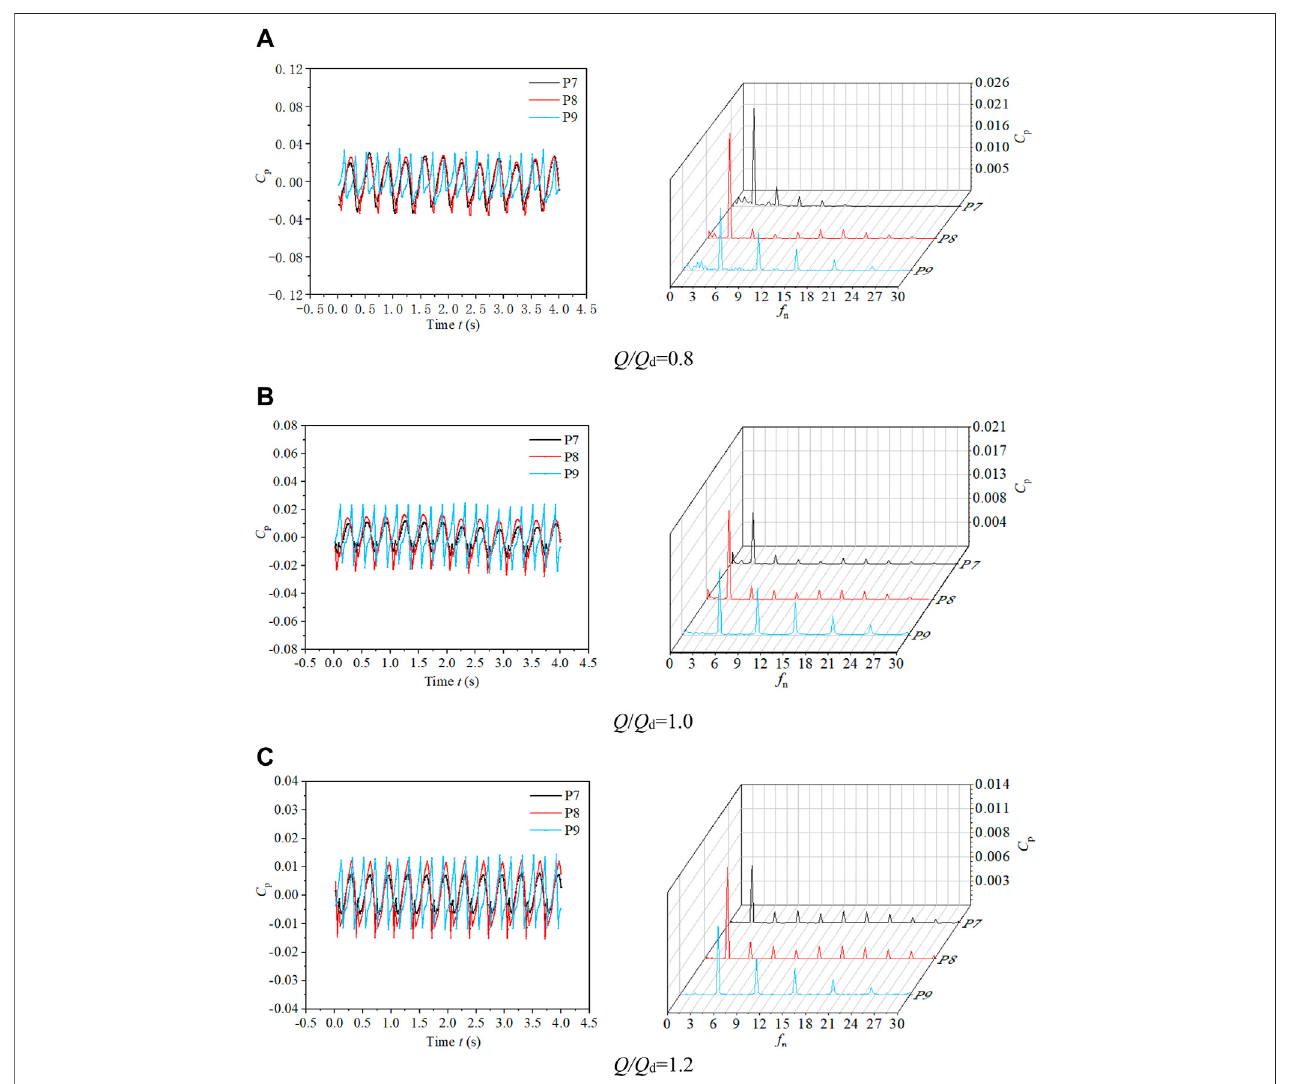
FIGURE13| Time domain chart and frequency domain chart ofpressurepulsationon theimpeller outlet at monitoring points P7-P9 under differentconditions. (A) Q/Q d = 0.8 (B) Q/Q d = 1.0 ( (C) Q/Q d =